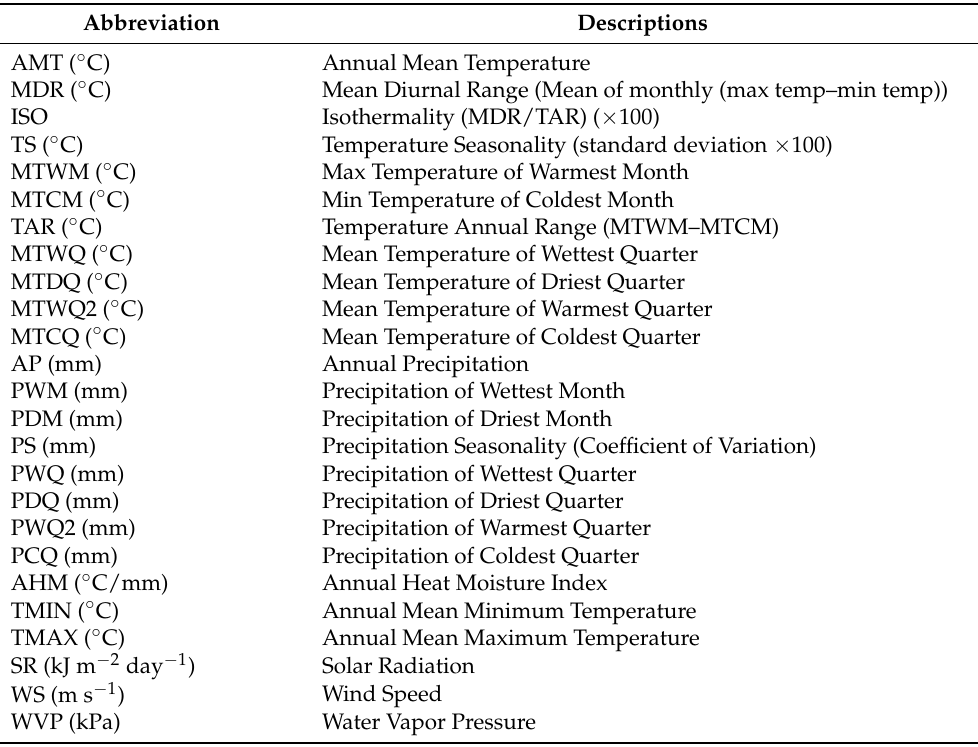
Table 2. Abbreviations and descriptions of candidate climate